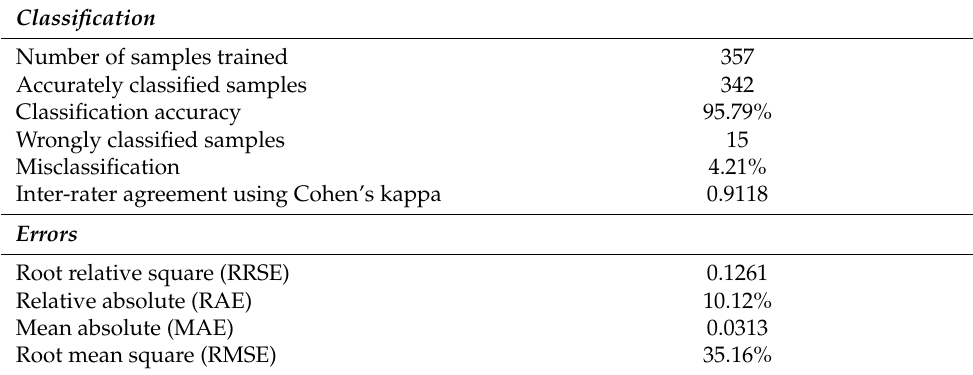
Table 7. Classification result of stratified cross validation.